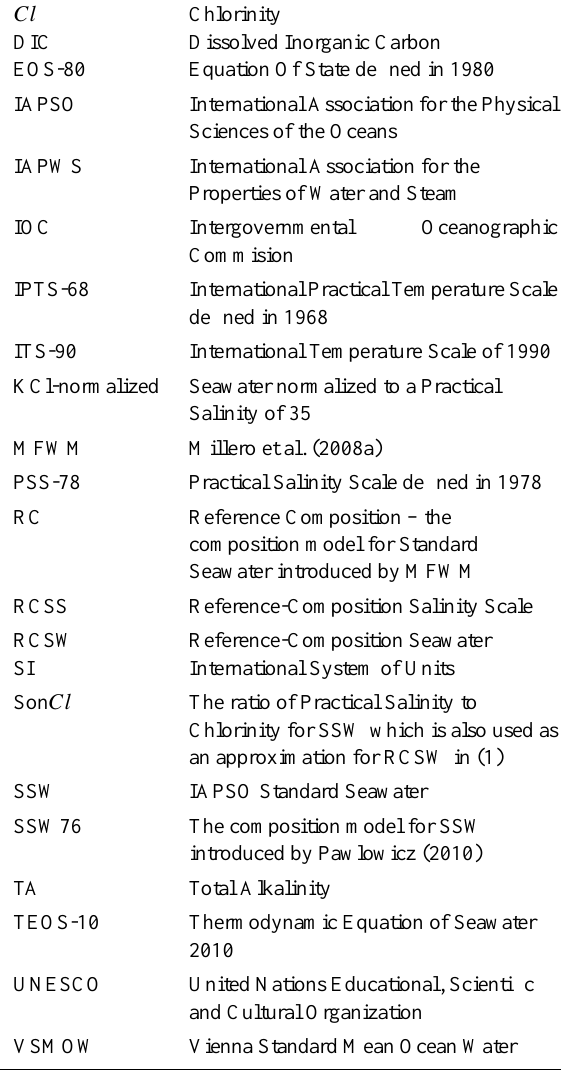
Table A2. Glossary of